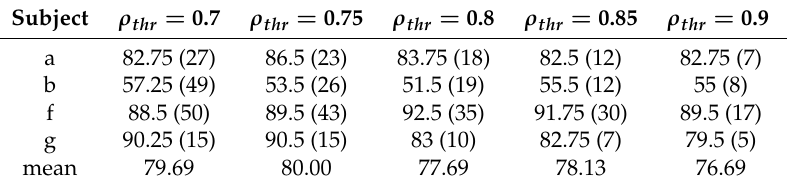
Table 6. Threshold and classification performance of proposed method for BCI Competition IV Dataset